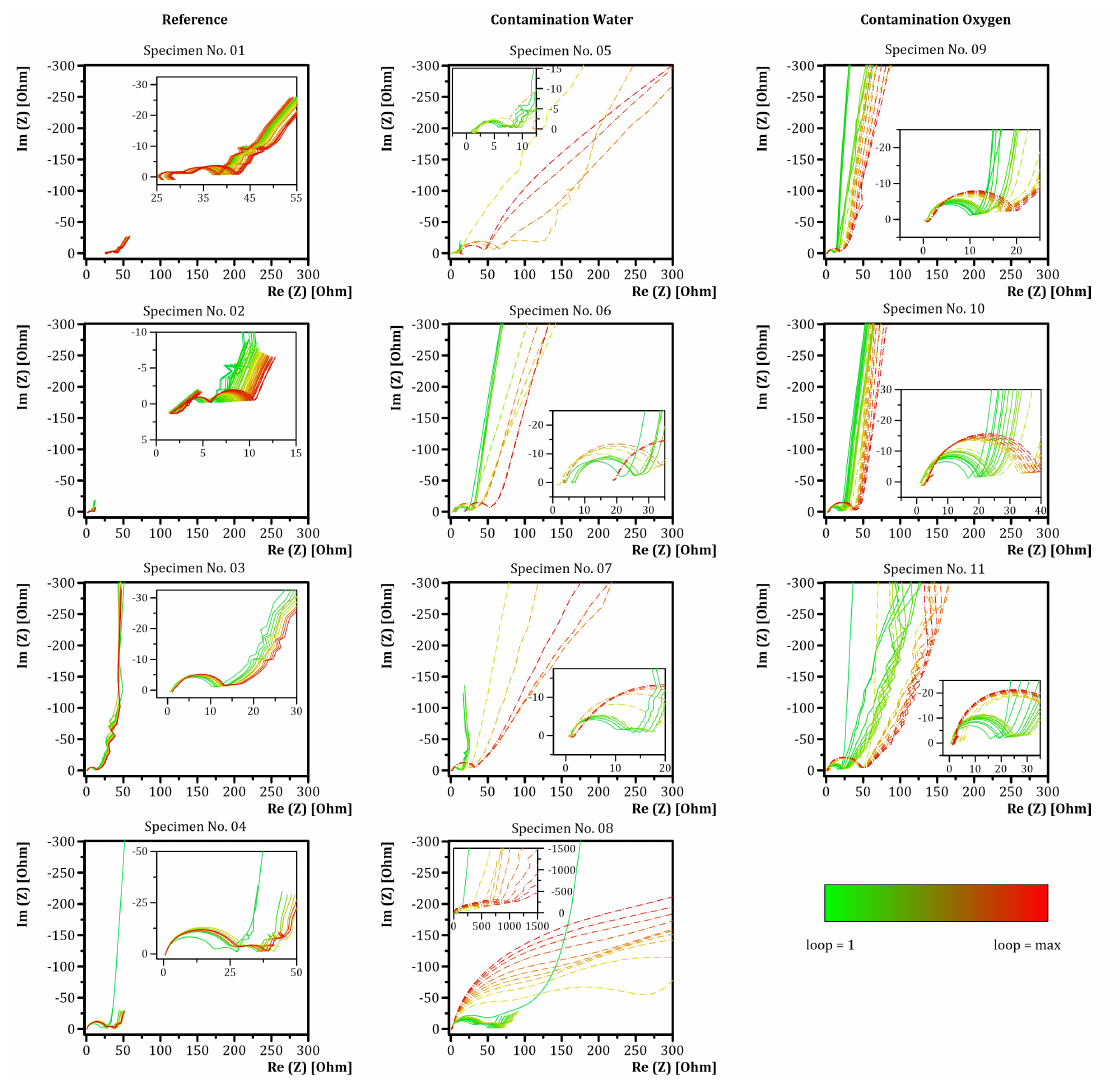
Figure 7. Electrochemical impedance spectra for specimens during cycling. First column—reference specimens. Second column—specimens with water contamination. Third column—specimens with oxygen contamination. A lower limit was indicated by the first loop. The upper limit can be taken from Table 2. The dashed line represents specimens after